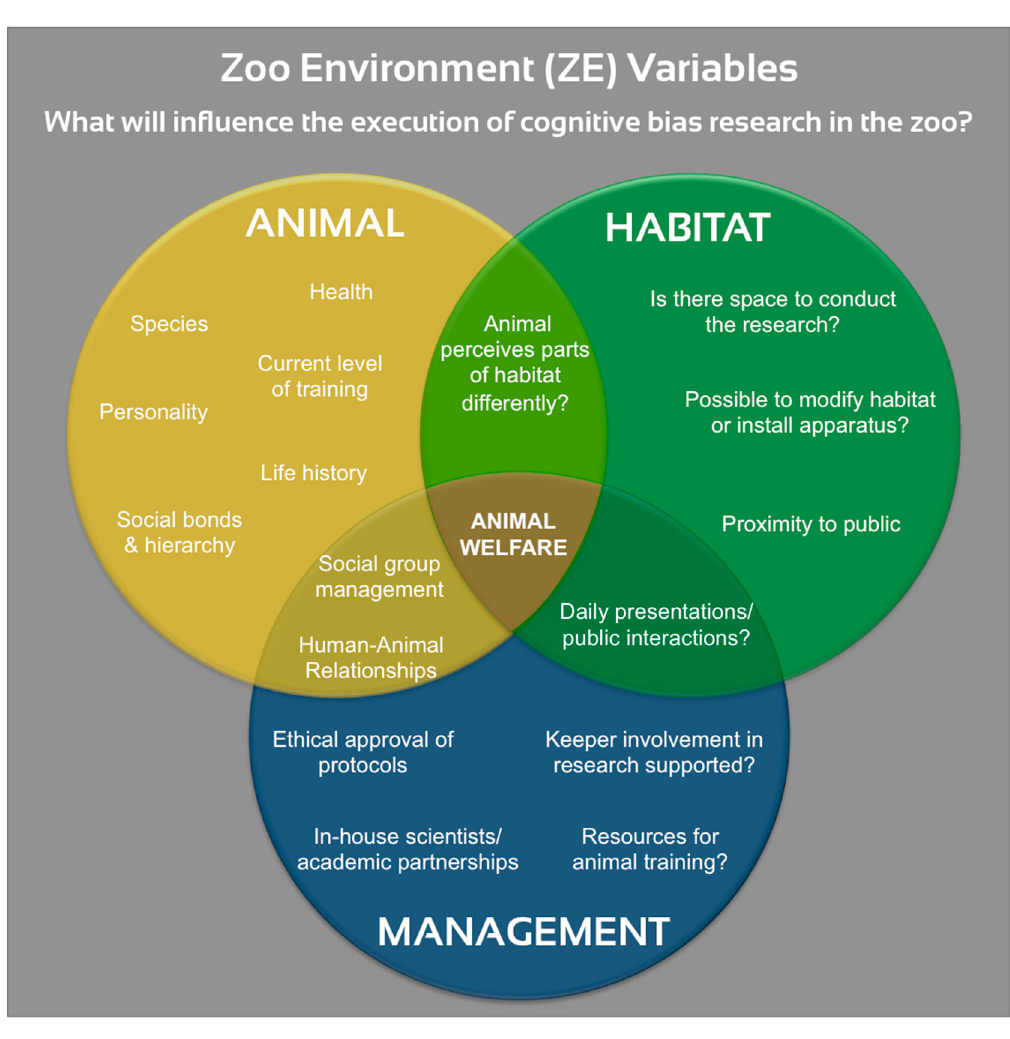
Figure 1. Venn Diagram showing the principal factors to influence cognitive bias studies in zoos, labelled the Zoo Environment (ZE) Variables.